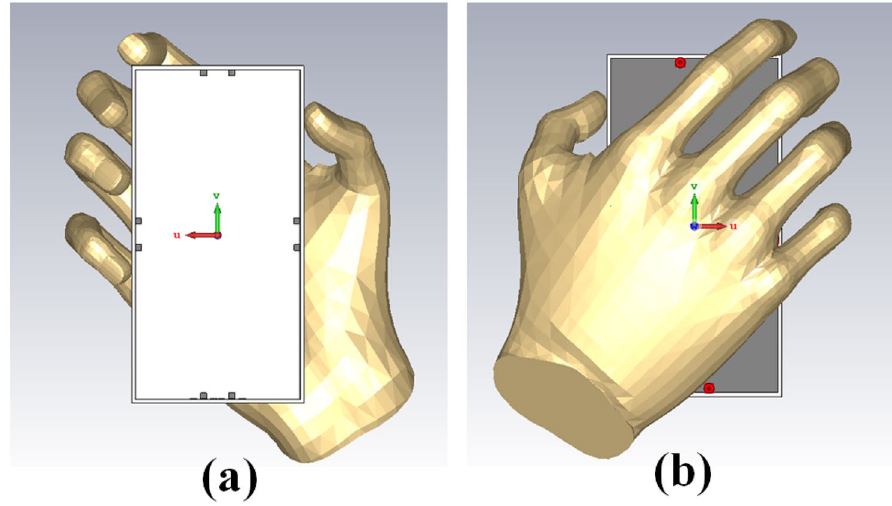
Figure 29. Hand effect on the mobile framed-based MIMO antenna ( a ) front view, ( b ) back view.